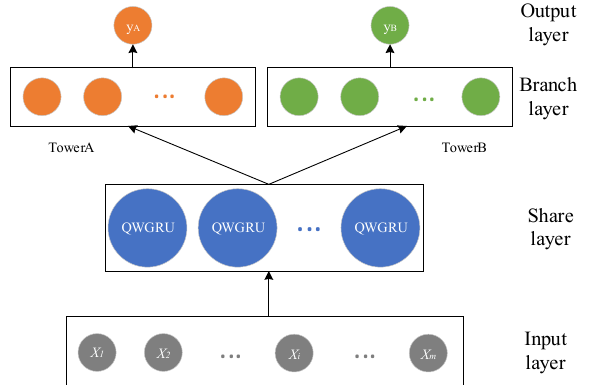
Figure 4. QWGRU-MTL structure diagram .